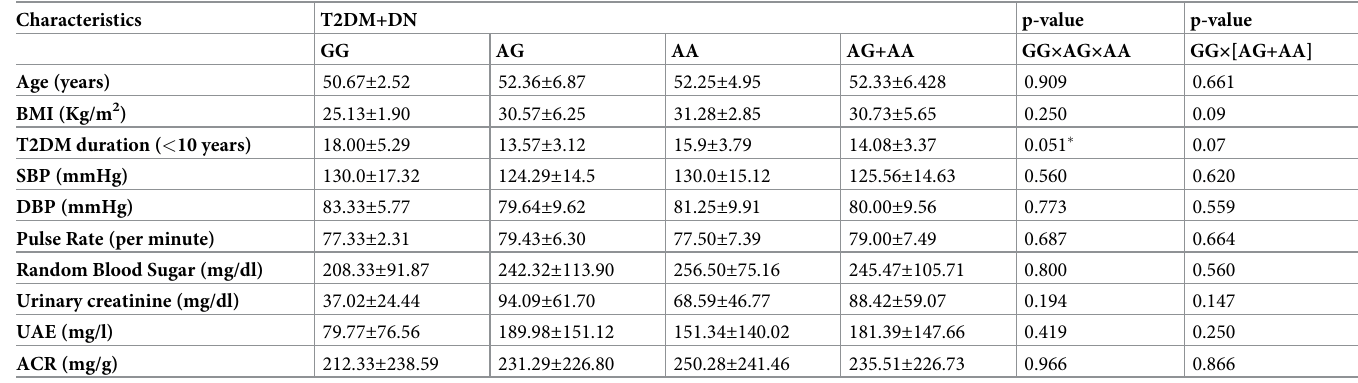
Table 6. Analysis of the influence of ACE2 G8790A polymorphism on clinical-biochemical variables in female T2DM patients with diabetic nephropathy. Characteristics